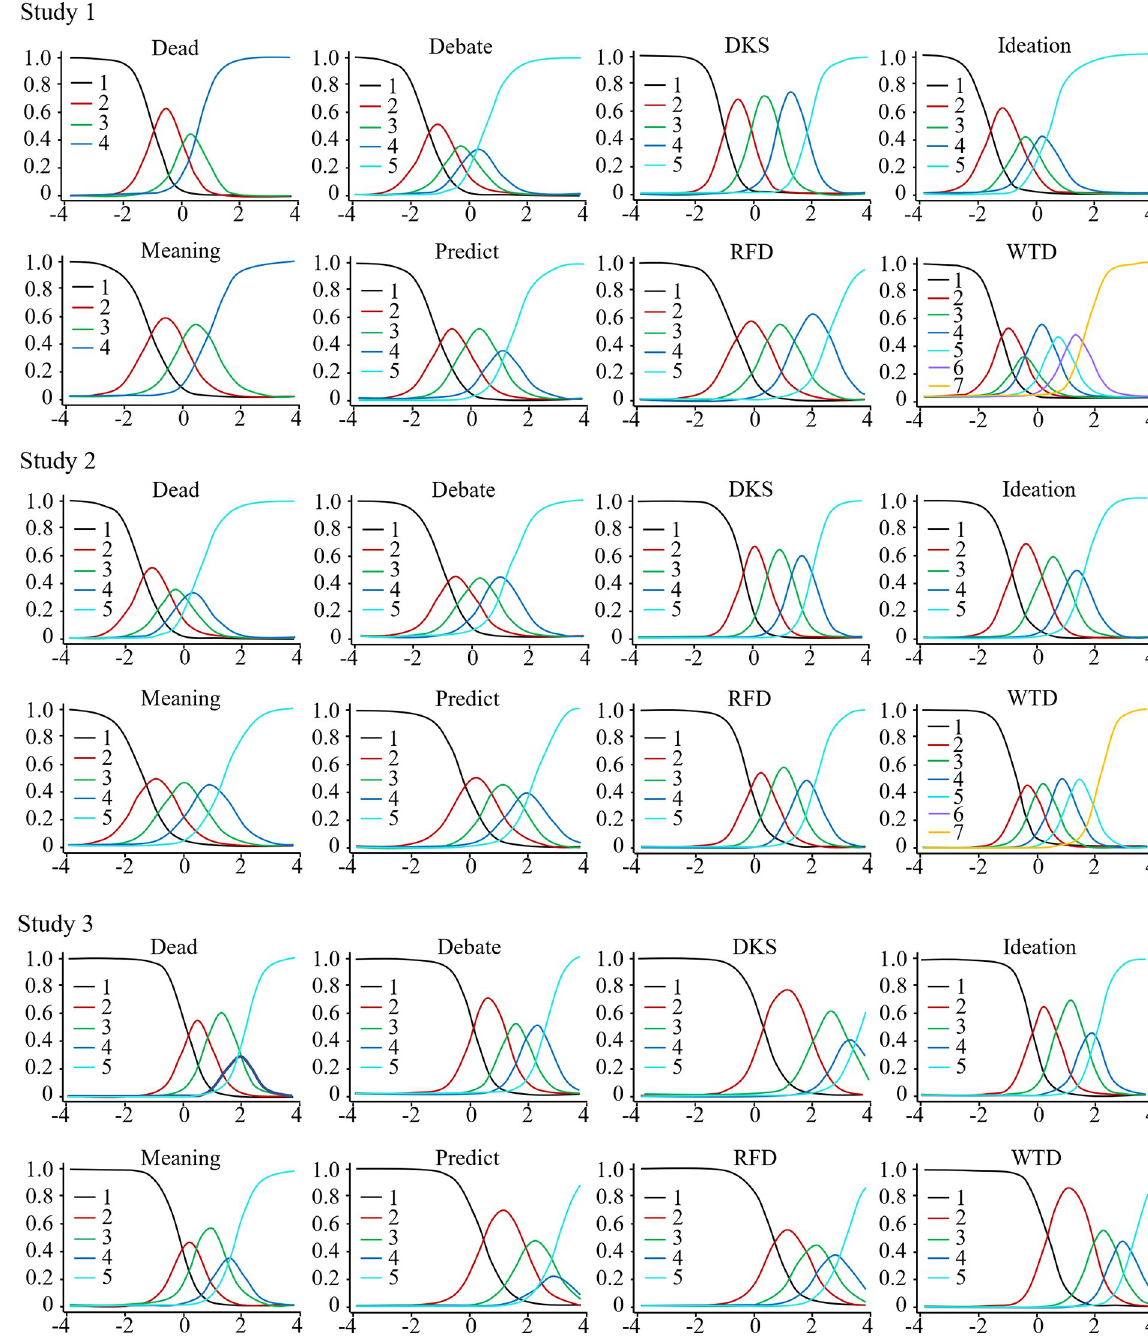
Fig 6. Suicidality Scale item response characteristic curves. Y-axes indicate probability of responding, x-axes indicate theta (latent trait